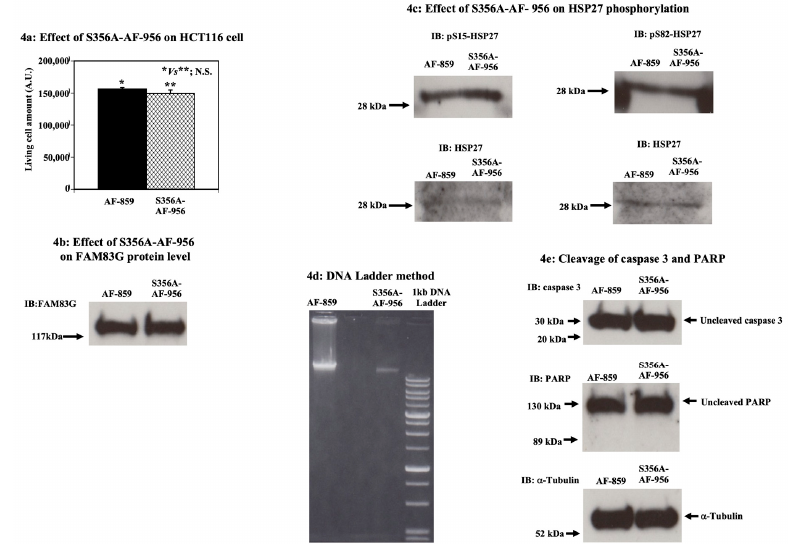
Figure 4. The e ff ect of the FAM83G S356A-AF-956 peptide on apoptosis in HCT116 cells. ( a ) E ff ect of S356A-AF-956 on HCT116 cells. The e ff ects of S356A-AF-956 (right column) and AF-859 (left column) peptide treatment (both 54 µ M) on HCT116 cells were not significantly di ff erent. The experiments were independently performed in triplicate. ( b ) E ff ect of S356A-AF-956 on FAM83G protein levels. Immunoblots show that the peptides AF-859 and S356A-AF-956 had no e ff ect on the endogenous FAM83G protein levels. The experiments were independently performed in triplicate. ( c ) E ff ect of S356A-AF-956 on HSP27 phosphorylation. Whole cell lysates from HCT116 cells treated with either AF-859 or S356A-AF-956 were analyzed by immunoblotting (IB) with antibodies specific for anti-phospho-(S15) HSP27 (top panel, left) and anti-phospho-(S82) HSP27 (top panel, right). IB with an HSP27-specific antibody: AF-859 and S356A-AF-956 treatments had similar e ff ects on HSP27 protein levels in HCT116 cells; thus, S356A-AF-956 treatment did not a ff ect S15 and S82 phosphorylation. The experiments were independently performed in triplicate. ( d ) S356A-AF-956 did not cause apoptosis in HCT116 cells (DNA Ladder analysis). Apoptotic DNA fragmentation was qualitatively analyzed using the DNA Ladder method. Lanes, left to right: AF-859-treated cells, S356A-AF-956-treated cells, and 1 kb DNA ladder marker. Analysis showed that S356A-AF-956-treated cells did not cause apoptosis. The experiments were independently performed in triplicate. ( e ) S356A-AF-956 did not cause apoptosis in HCT116 cells (cleavage of caspase 3 and PARP proteins). Cells treated with S356A-AF-956 showed no change in both caspase 3 and PARP protein cleavages. Top panel: levels of uncleaved caspase 3 proteins (arrow) following the treatment of HCT116 cells with AF-859 (left lane) and S356A-AF-956 (right lane). Middle panel: levels of uncleaved PARP proteins (arrow) following the treatment of HCT116 cells with AF-859 (left lane) and S356A-AF-956 (right lane). Bottom panel: α -tubulin IB shows equivalent protein loading in each lane. The experiments were independently performed in